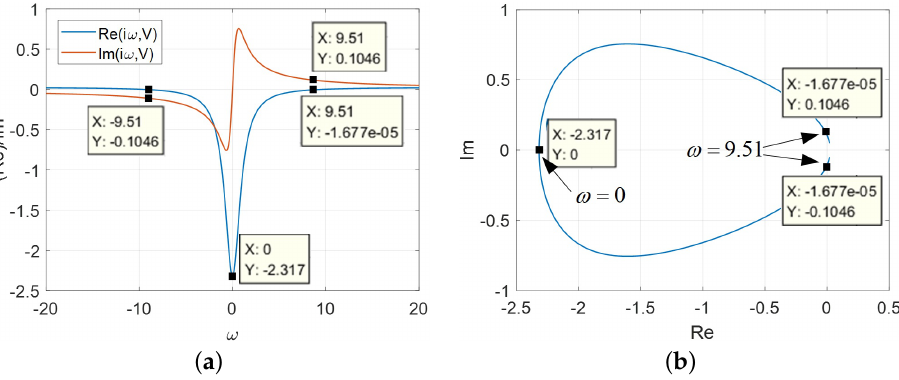
Figure 15. The frequency response ( A = A FS < A M ): ( a ) Re [ Y ( i ω , V )] and Im [ Y ( i ω , V )] for − 20 < ω ∗ < 20; ( b ) Re [ Y ( i ω ∗ , V )] vs . Im [ Y ( i ω ∗ , V )] .